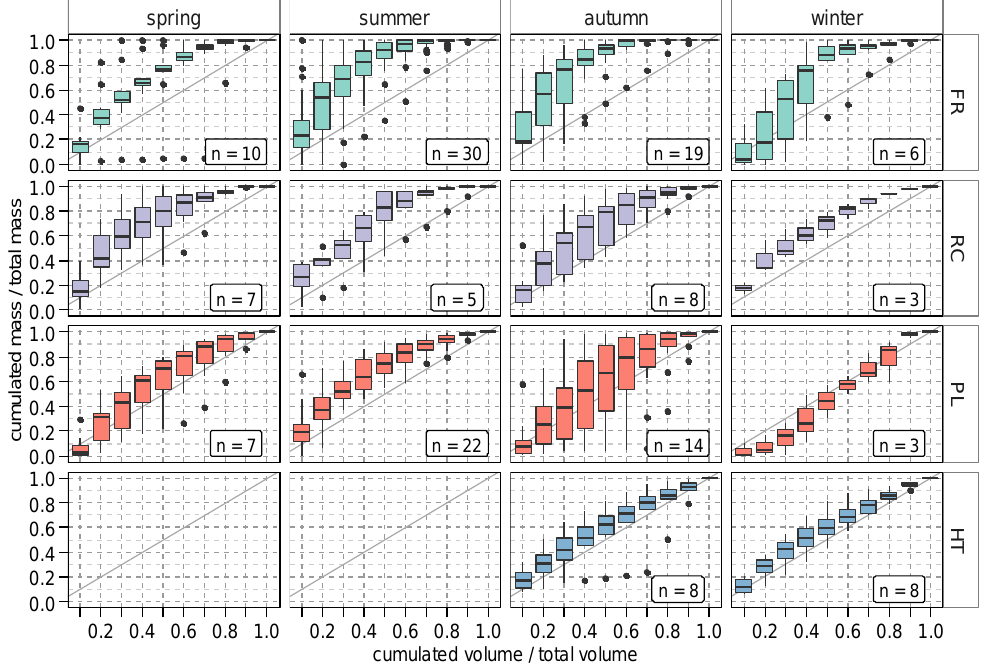
Figure 4. Seasonal- (horizontal) and site- (vertical) specific boxplots of M ( V )-curve distributions at runoff volume quantiles (FR: flat roof, RC: residential catchment, PL: parking lot, HT: high-traffic street). Box ranges correspond to the first and third quartiles. Median is indicated by a solid black horizontal line. Whiskers comprise lowest/highest value within 1.5 × inter ‐ quartile range (IQR). Outliers exceed whiskers’ ends and are indicated by solid black dots.